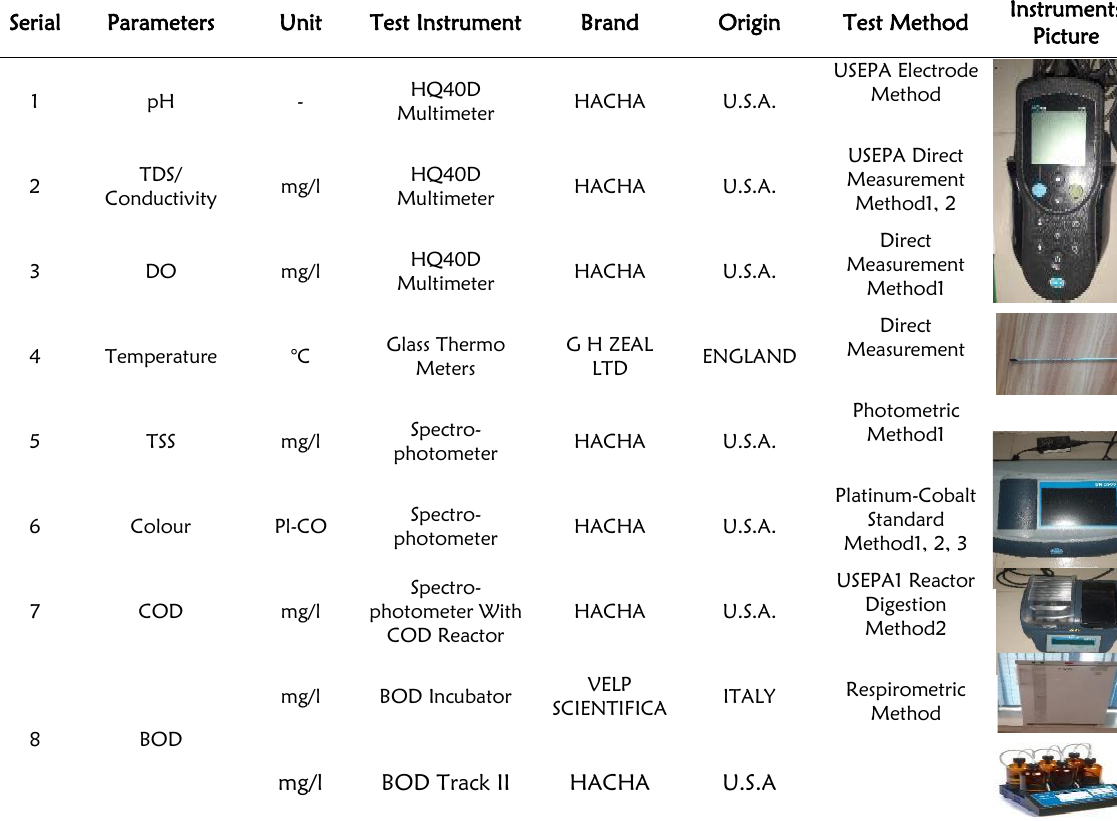
Table 2: Instruments details with test